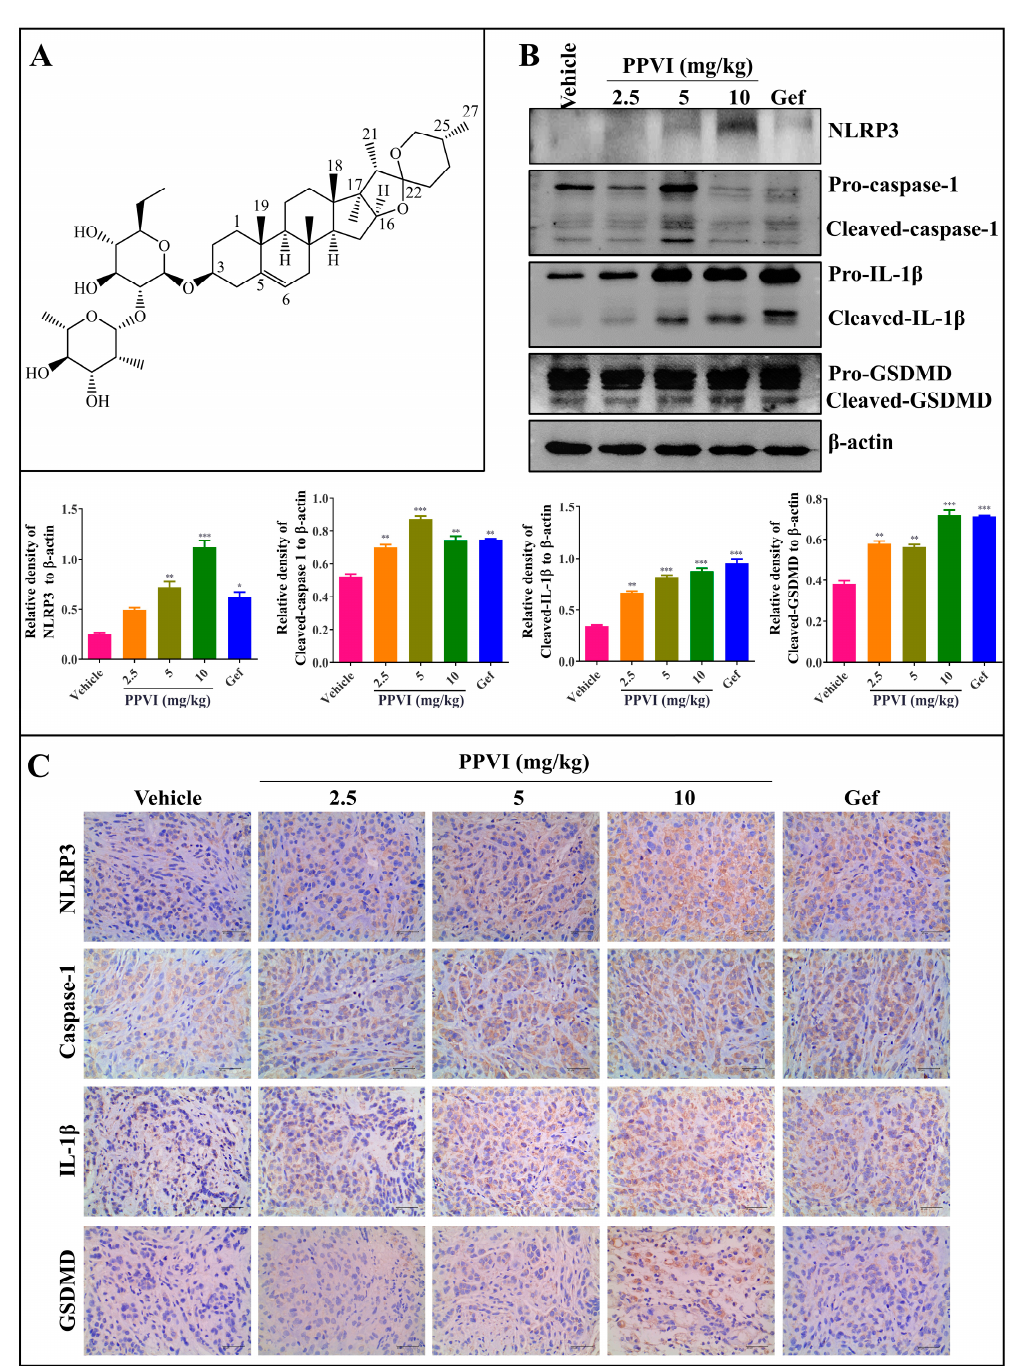
Figure 1. Polyphyllin VI (PPVI) activates the NLRP3 inflammasome in A549 bearing athymic nude mice. ( A ) Chemical structure of PPVI. ( B ) Tumor tissue lysates were analyzed by Western blot for NLRP3, caspase-1, IL-1 β , GSDMD and β -actin. Bar chart indicates the relative density of the protein to β -actin; bars, S.D. ** p ≤ 0.01; *** p ≤ 0.001. The full-length Western blotting images are